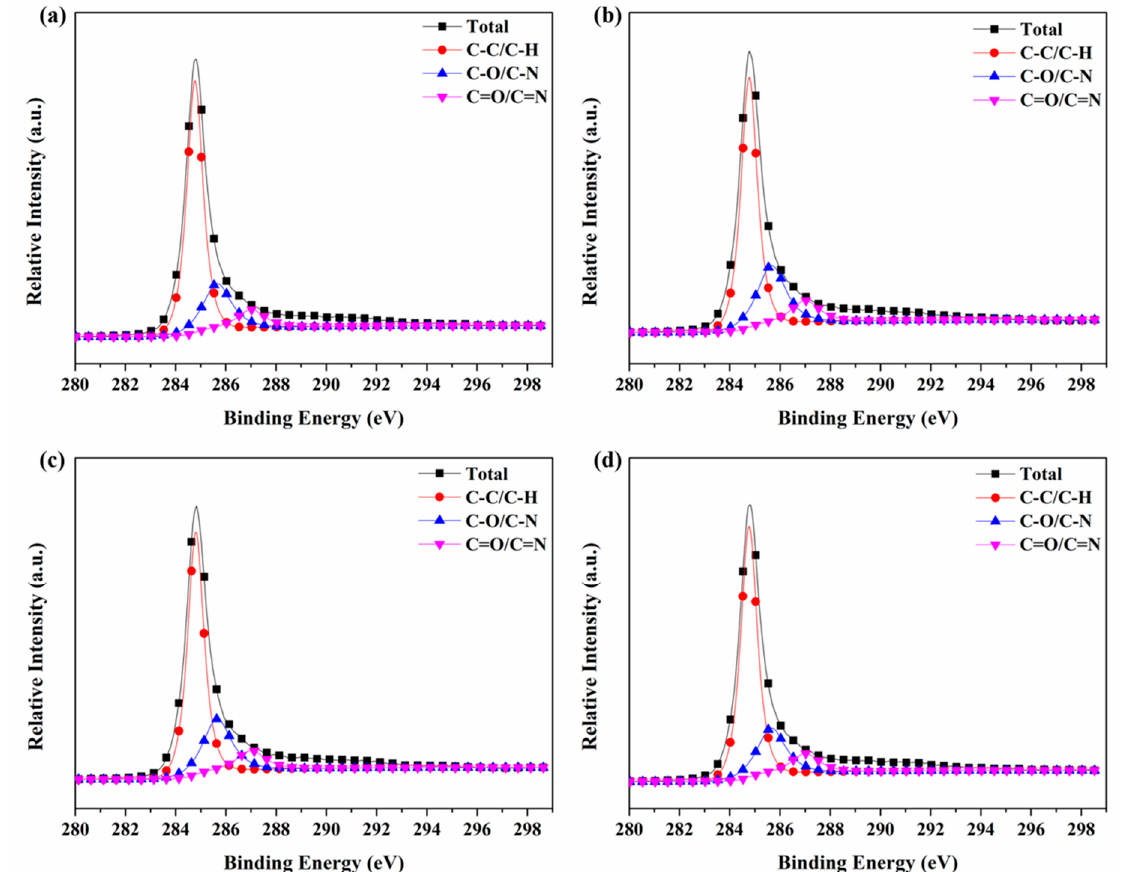
Figure 9. C1s spectra of each carbonaceous deposit layer in the coking chamber: ( a ) #1 carbonaceous deposit layer; ( b ) #2 carbonaceous deposit layer; ( c ) #3 carbonaceous deposit layer; and ( d ) #4 carbonaceous deposit layer.